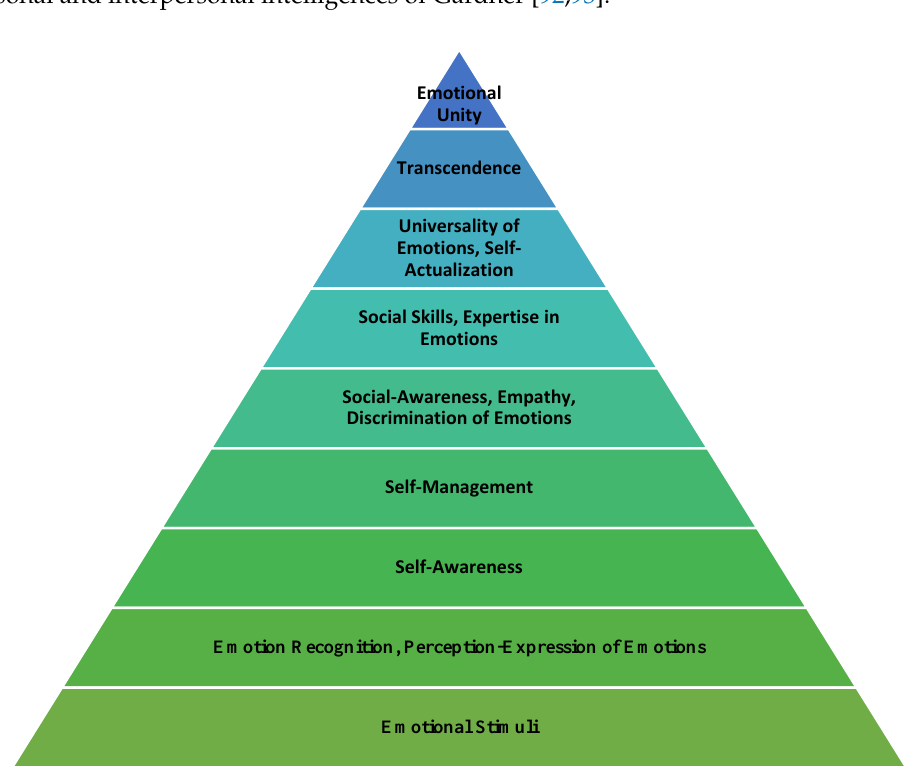
Figure 1. The emotional intelligence pyramid (9-layer model).